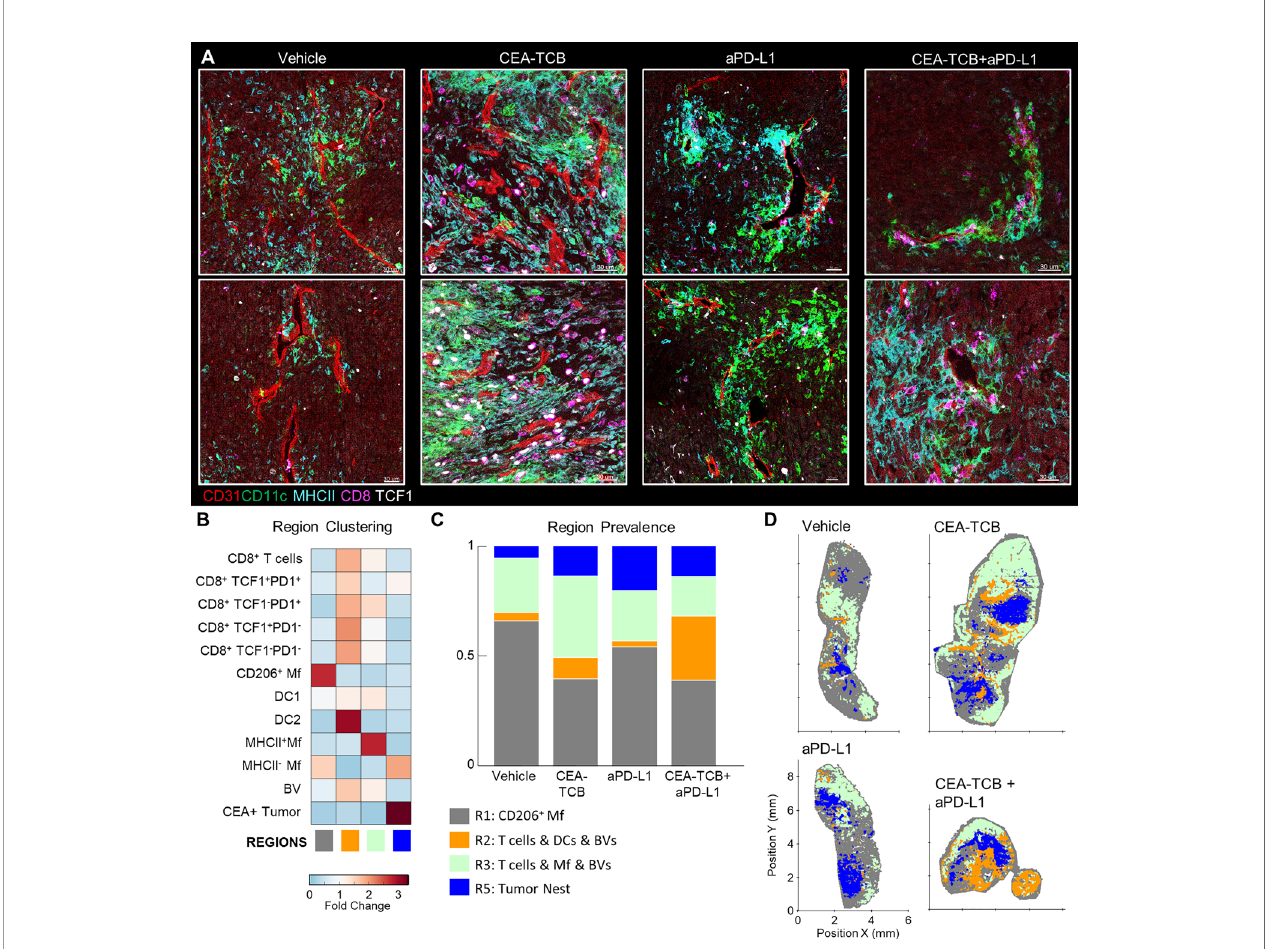
FIGURE 4 | Perivascular immune niches in MC38-CEA tumors. (A) Multiplex confocal images showing the association between TCF1 +/- CD8 T cells and DCs (CD11c+ MHCII+) with CD31+ blood vessels (BVs) across the different treatment conditions. (B) Neighborhoods (50µm) were clustered into regions and plotted on a region heatmap. Plot displays fold change of object density per neighborhood across all samples for each region. (C) Region prevalence in each sample. (D) Positional plots of all neighborhoods for selected samples, color-coded by region classi fi cation de fi ned in panel (B)